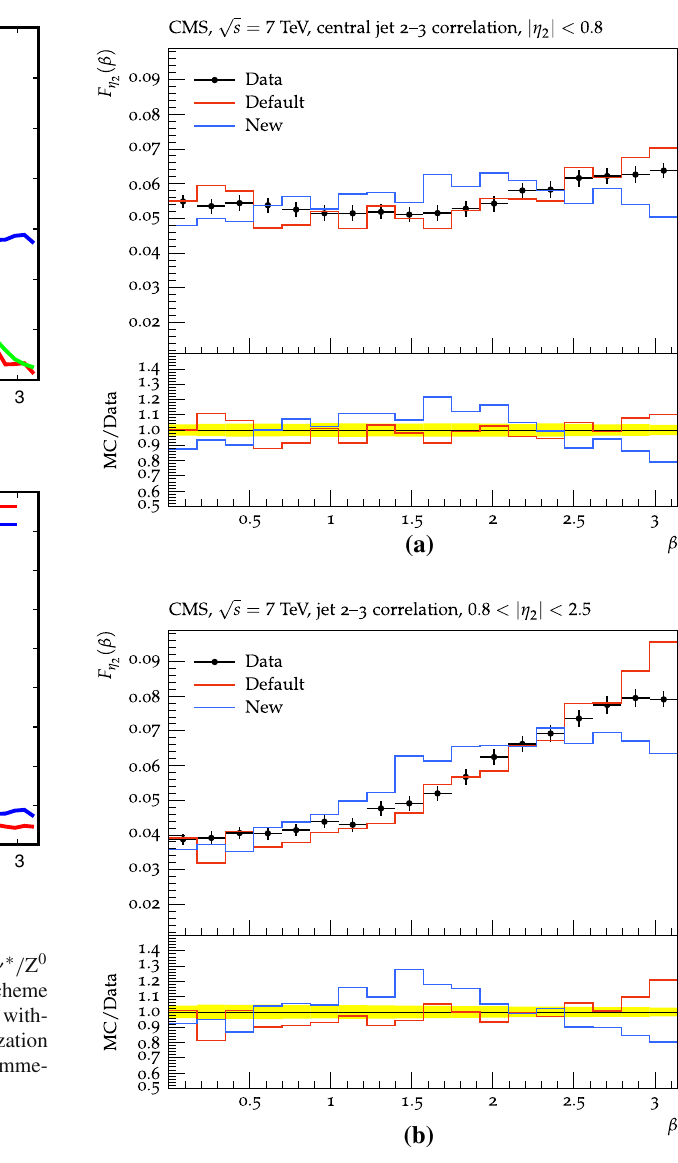
Fig. 8 Angular correlation betweenthe second andthird jetsmeasured by CMS for pp collisions at 7 TeV [44,45]. The new and default proce- dures are compared, with all azimuthal asymmetries included. (Results are for QCD 2 → 2 events, generated with ˆ p ⊥ > 60 GeV, that survive the experimental